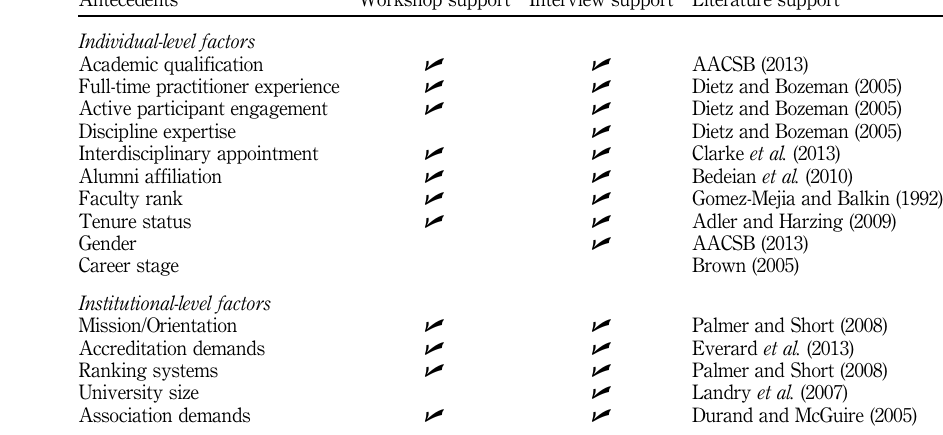
Table II. Individual and institutional level